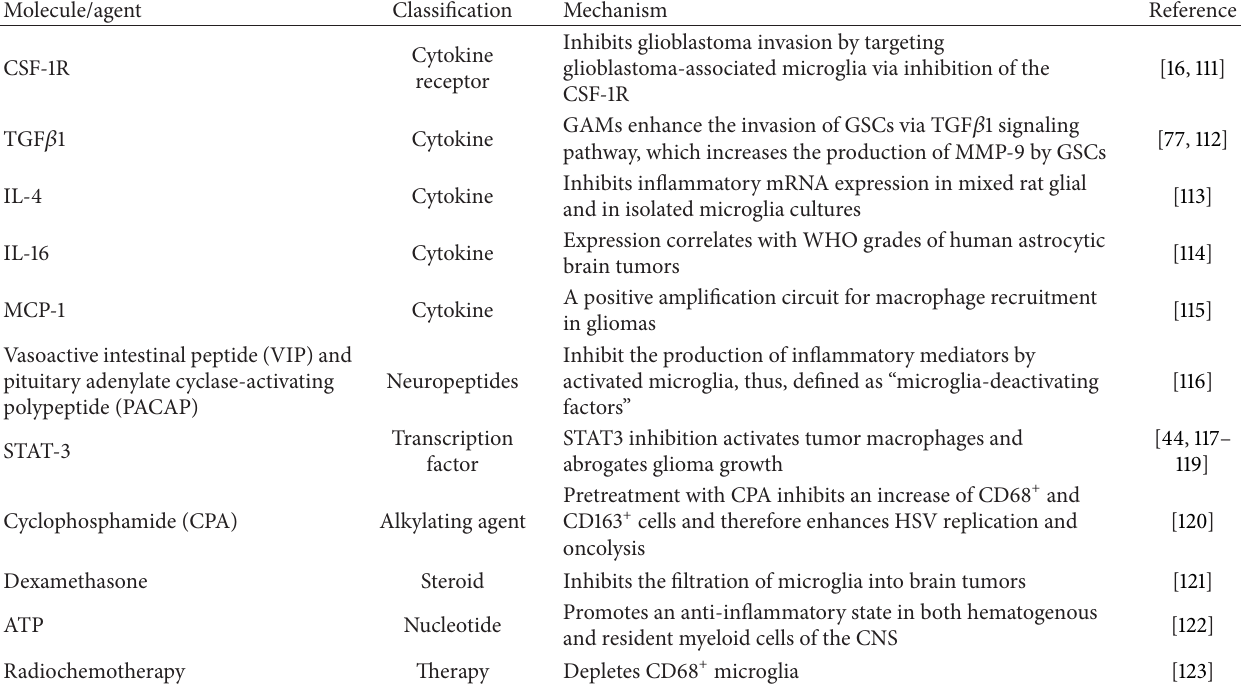
Table 2: Molecules/targets in GAMs for therapeutic